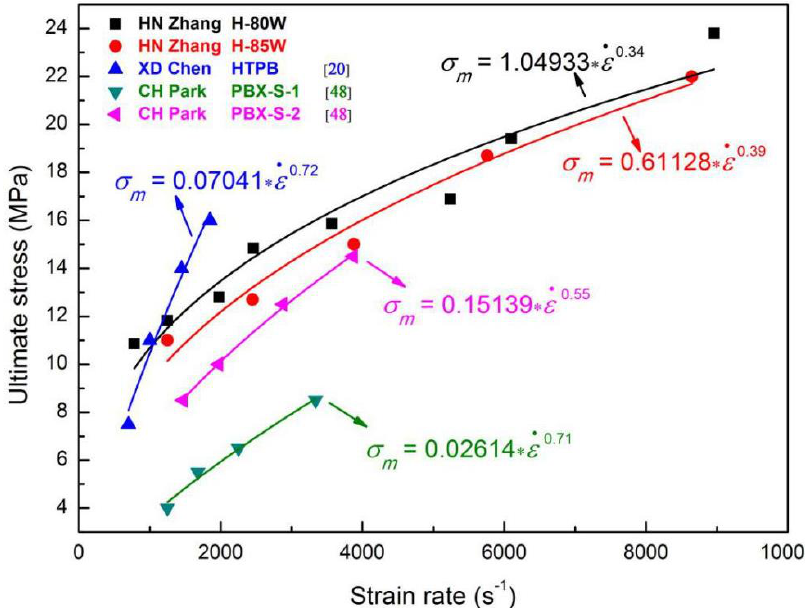
Figure 13. The rate-dependent relations of ultimate stress fitted by Equation (3) for H-80W, H-85W and other reported HTPB based materials.